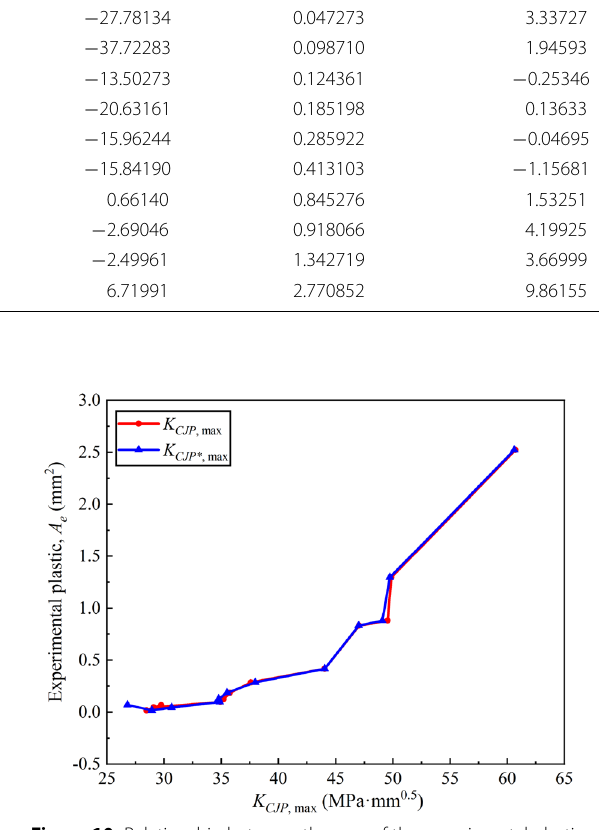
Figure 9 Relationship between relative error and experimental plastic zone area